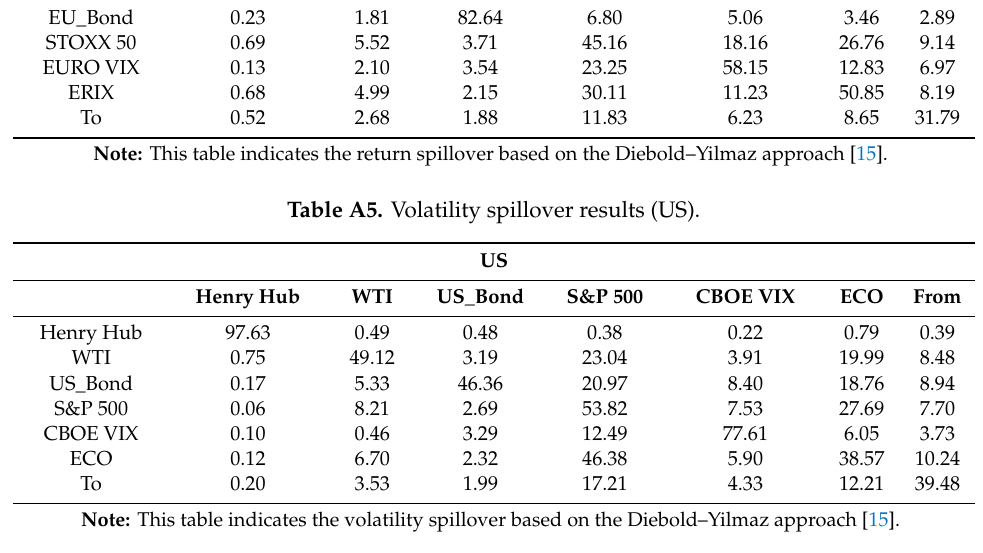
Table A6. Volatility spillover results